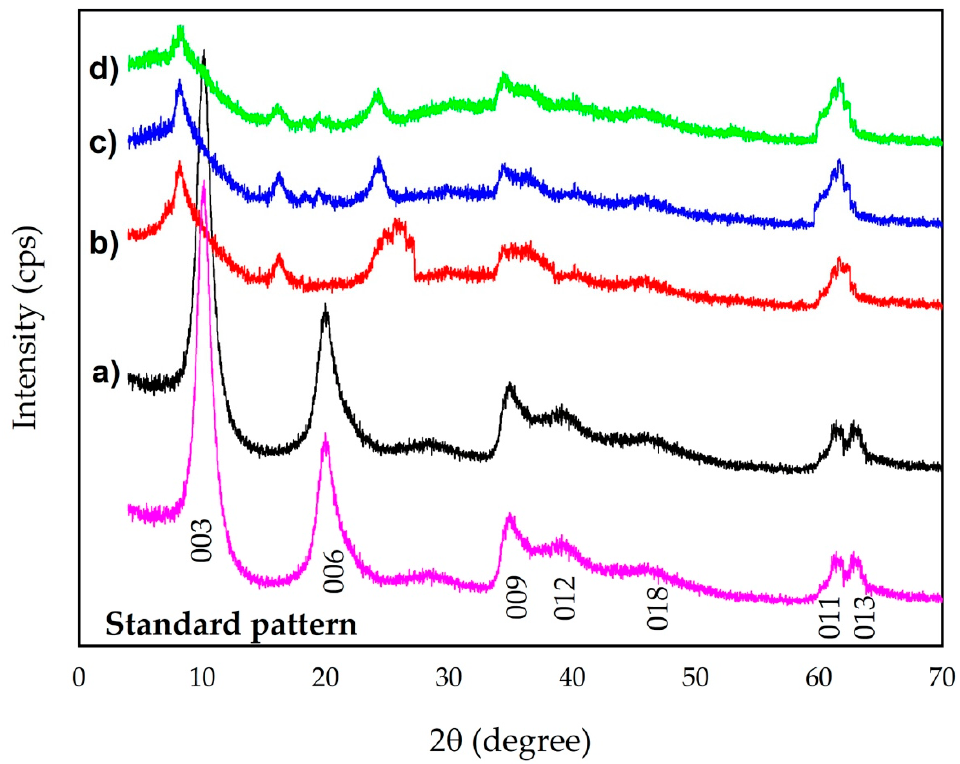
Figure 1. XRD patterns of the LDH materials in comparison with the standard pattern Mg-Al-NO 3 − —LDH [20] ( a ) Mg-Al-LDH, ( b ) Mn 2+ /Zn 2+ /Fe 3+ /Mg-Al-LDH composite, ( c ) P-loaded Mn 2+ /Zn 2+ /Fe 3+ /Mg-Al-LDH composite and ( d ) P ions-loaded Mn 2+ /Zn 2+ /Fe 3+ /Mg- Al-LDH